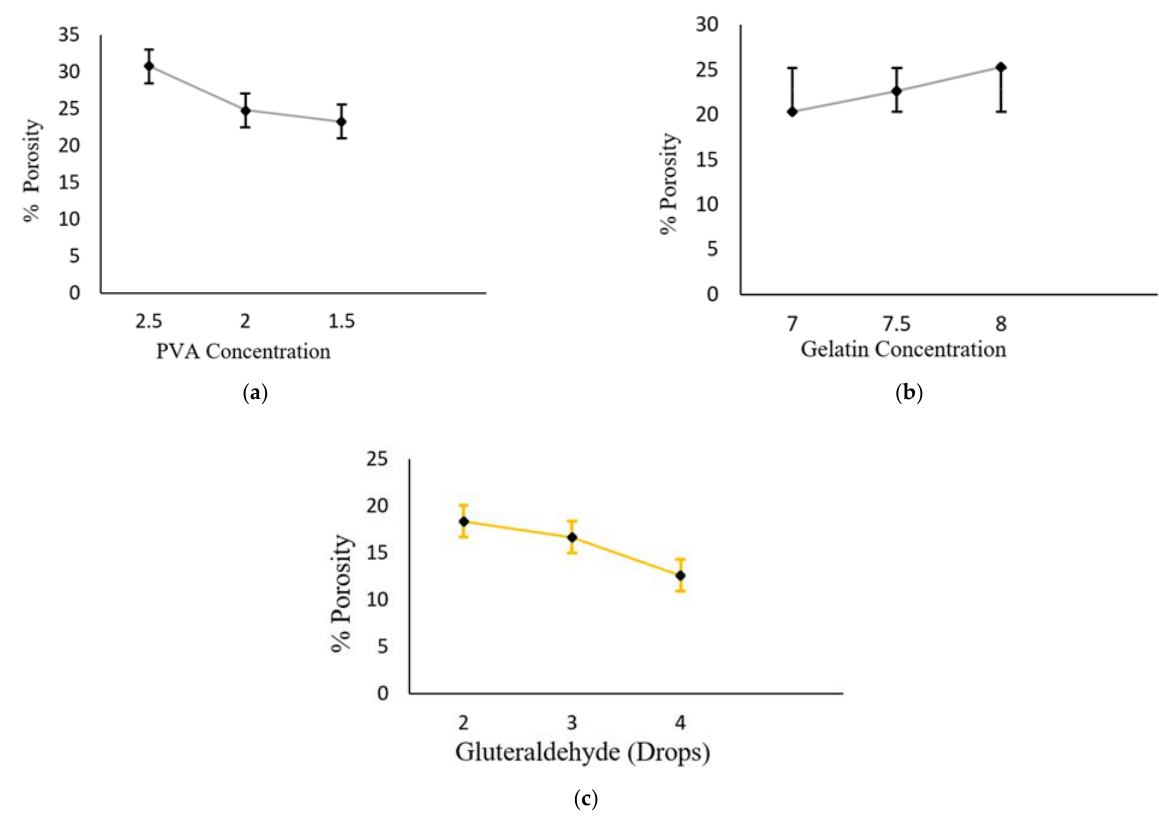
Figure 3. Percentage of porosity of Gel/PVA hydrogel with ( a ) decreasing concentration of PVA, ( b ) increasing concentration of Gel, ( c ) increasing quantity of glutaraldehyde. Data are expressed as mean ± S.D. and p < 0.01 is considered statistically significant.